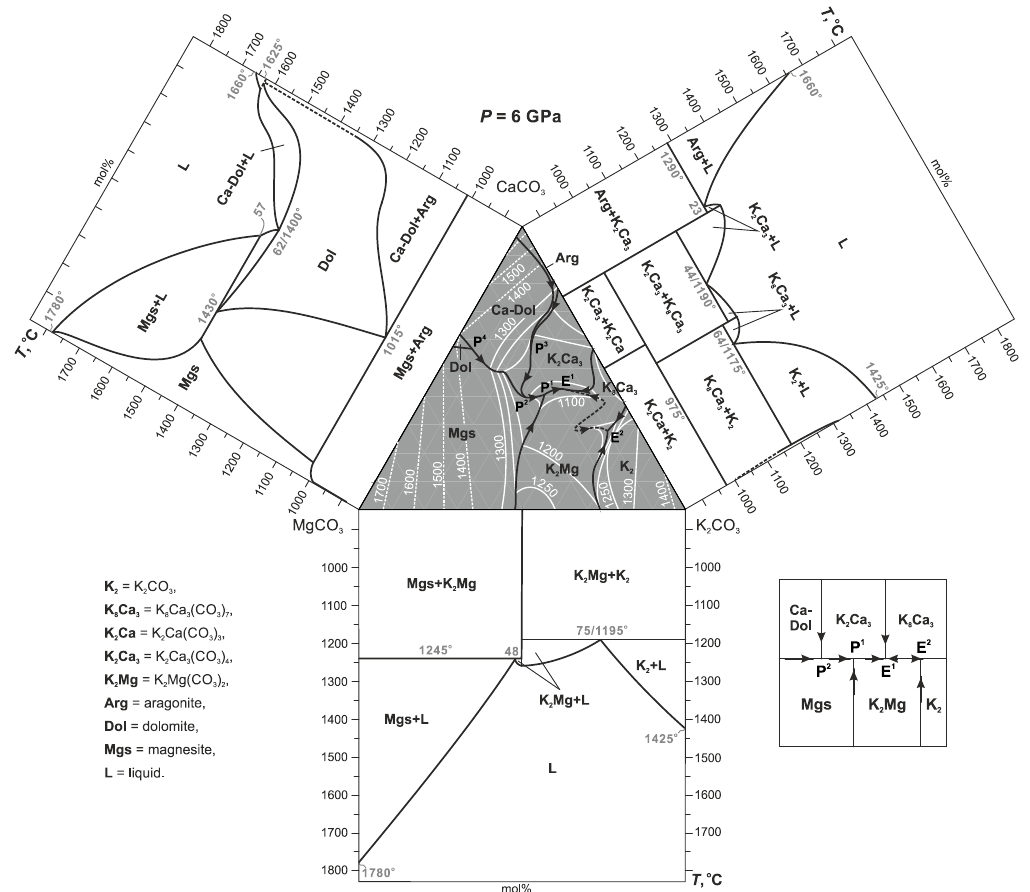
Figure 6. Liquidus phase relations in the system K 2 CO 3 – MgCO 3 – CaCO 3 at 6 GPa. Black are boundary lines and white lines are liquidus isotherms with temperatures in degrees Celsius. Dashed lines were inferred. The phase relations in the corresponding binaries are from [35,36,38,43]. The relative position of peritectic and eutectic points is shown on the schematic sketch at the right-bottom. See the Nomenclature section for abbreviations.